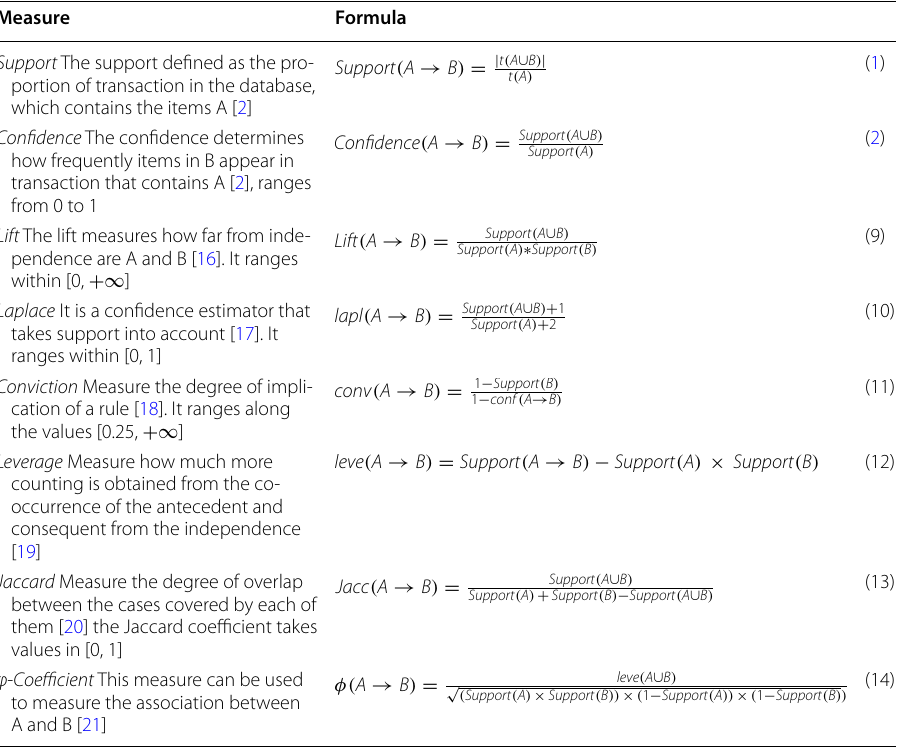
Table 2 Quality measurements of association rules Measure